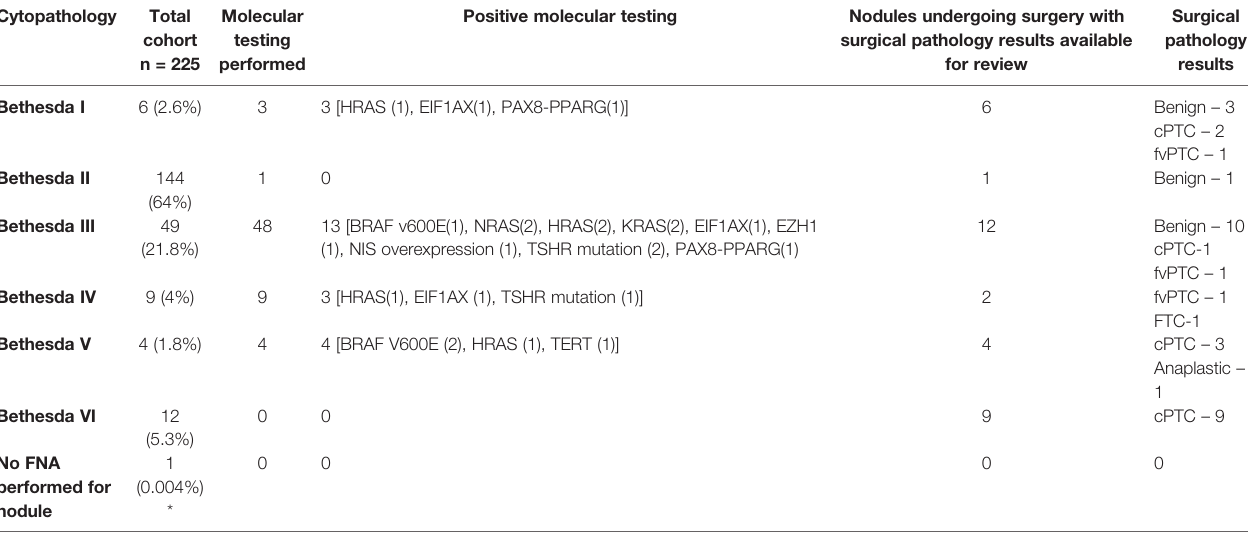
TABLE 2 | Cytology, molecular testing and surgical pathology outcomes for thyroid nodules.